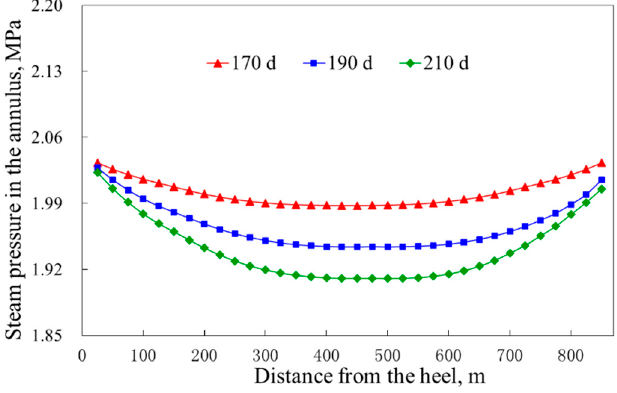
Figure 15. Effect of the injection time on the annulus pressure profiles of the injector.